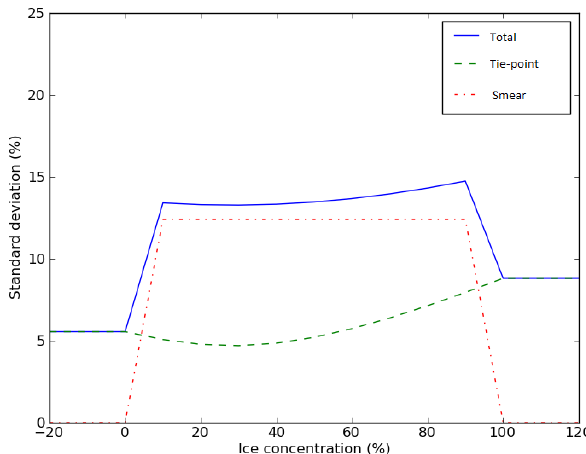
Figure 3. The total uncertainty in blue and its two components: the smearing uncertainty in red and the tie-point uncertainty in green as a function of ice